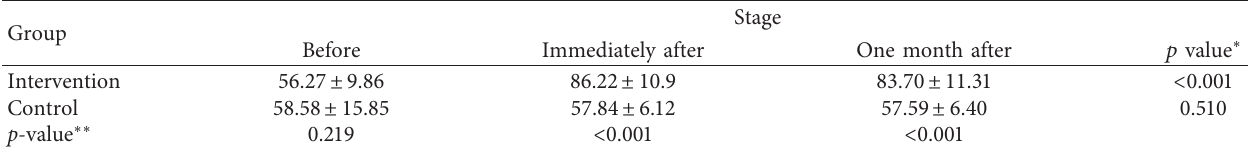
Table 2: A comparison between the satisfaction mean scores of the control and intervention groups as measured in three stages: before, immediately after, and one month after intervention.